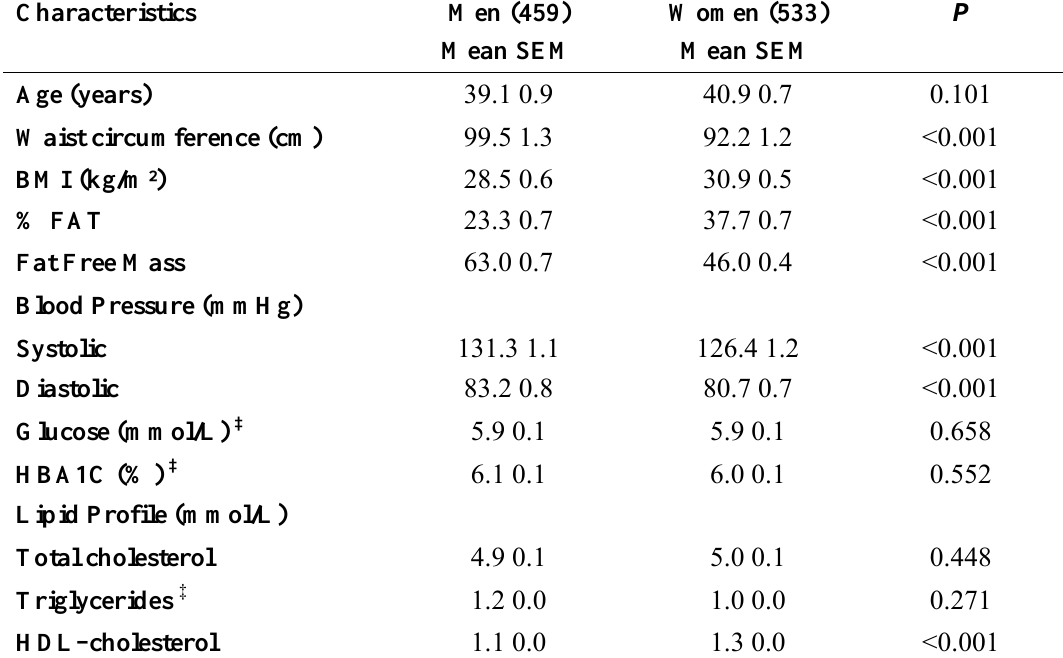
Table 1. Background characteristics of Kuwaiti adults by